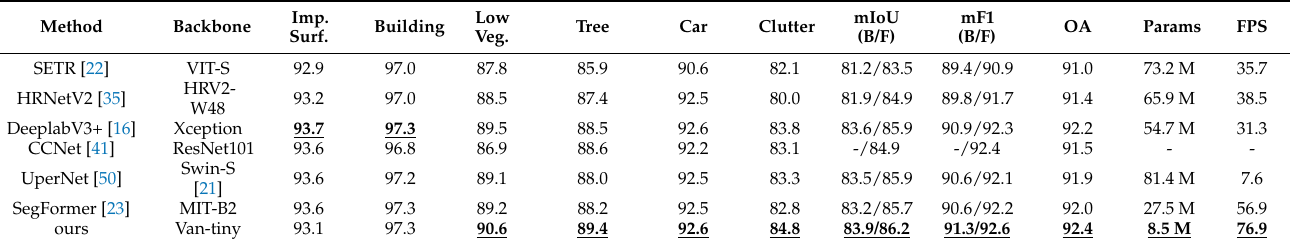
Table 9. Comparison with the state-of-the-art networks on the Potsdam dataset.